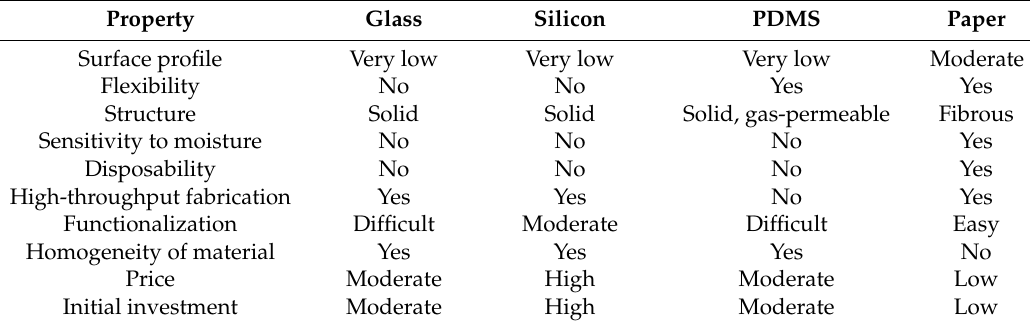
Table 2. Comparison of glass, silicon, PDMS and paper as a sensor-substrate (redrawn from [21]). Property Glass Silicon PDMS Paper Surface profile Very low Very low Very low Moderate Flexibility No No Yes Yes Structure Solid Solid Solid, gas-permeable Fibrous Sensitivity to moisture No Disposability No No Yes High-throughput fabrication Yes Yes Yes Functionalization Difficult Moderate Difficult Easy Homogeneity of material Initial investment